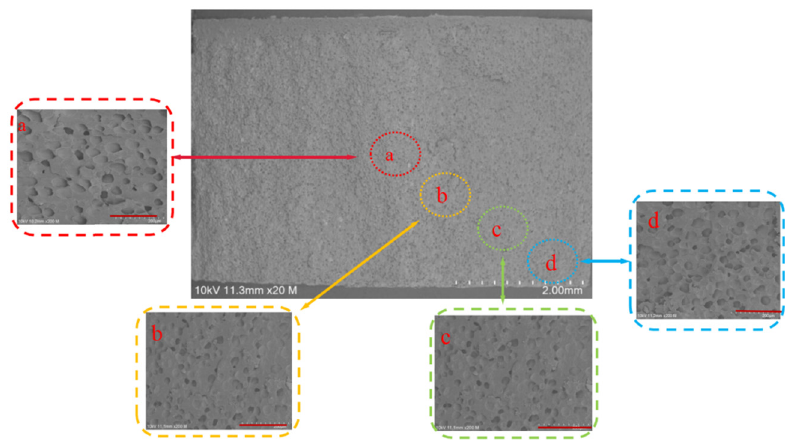
Figure 12: Structure of cells in di ff erent regions of the same isothermal